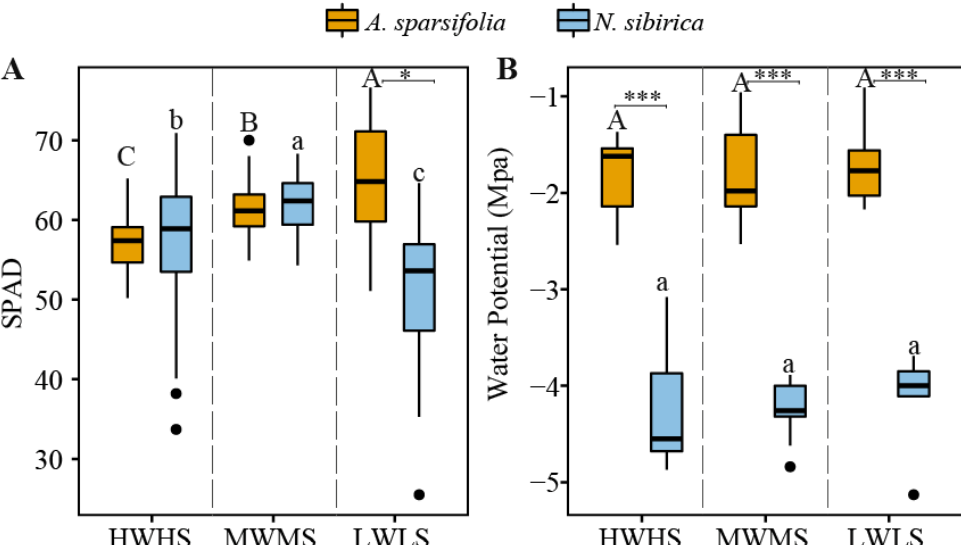
Figure 2. Changes in SPAD and water potential of leaves. ( A ) The changes of SPAD of N. sibirica and A. sparsifolia ; ( B ) The changes of water potential of N. sibirica and A. sparsifolia. The error bars show the standard deviations of the means. Different lowercase letters (a, b, c) above the error bars indicate the same index of N. sibirica under different plots ( p ≤ 0.05). Different capital letters (A, B, C) above the error bars indicate the same index of A. sparsifolia under different plots ( p ≤ 0.05). *, *** indicate that F values were significant between N. sibirica and A. sparsifolia at p ≤ 0.05, 0.001, respec- tively.